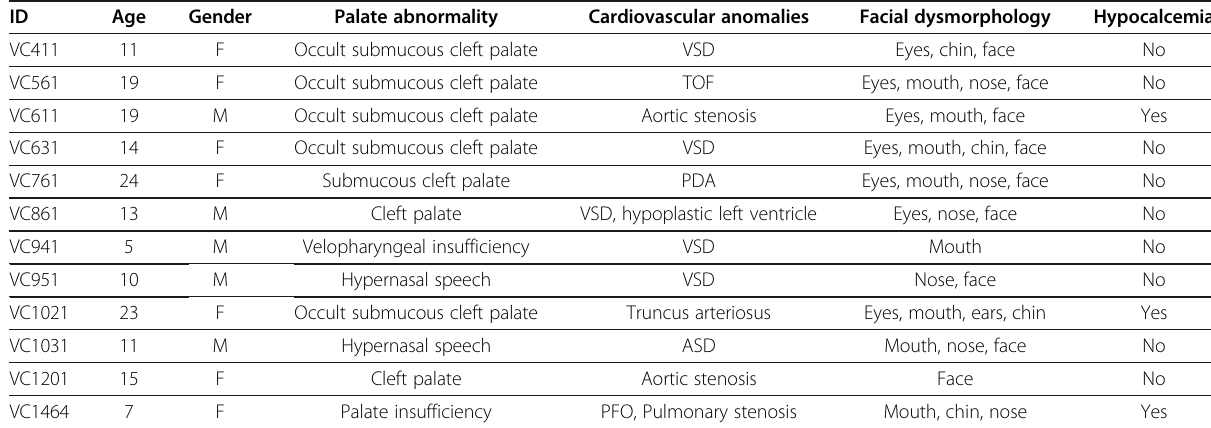
Table 4 Clinical data of individuals without 22q11.2